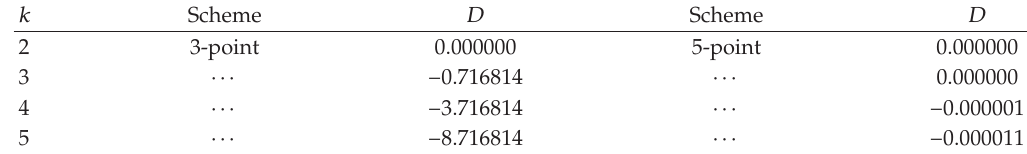
Table 1: Measure of deviation of convexity of 3-point and 5-point ternary scheme. Here k presents the level of iteration and D is measure of